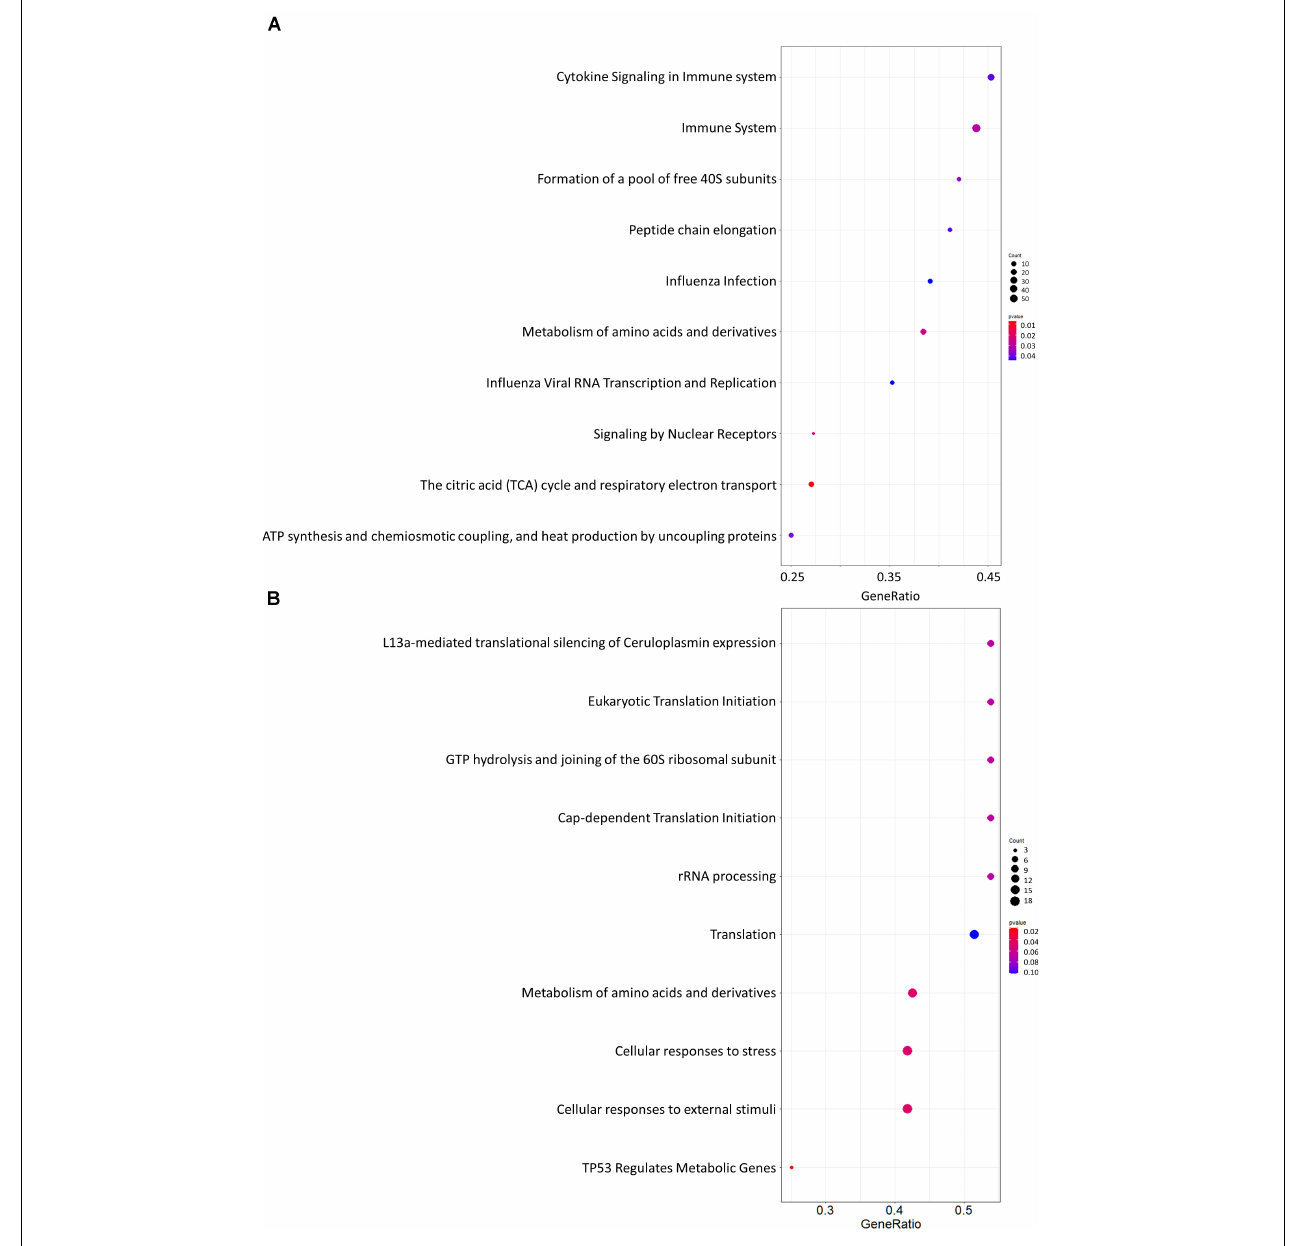
FIGURE 5 | Dot plots for the GSEA results. (A) Whole network; (B) selection of nodes altered in Parkinson’s disease patients. Dot size is proportional to the number of overlapping genes. P -values are color-coded according to the color scale.